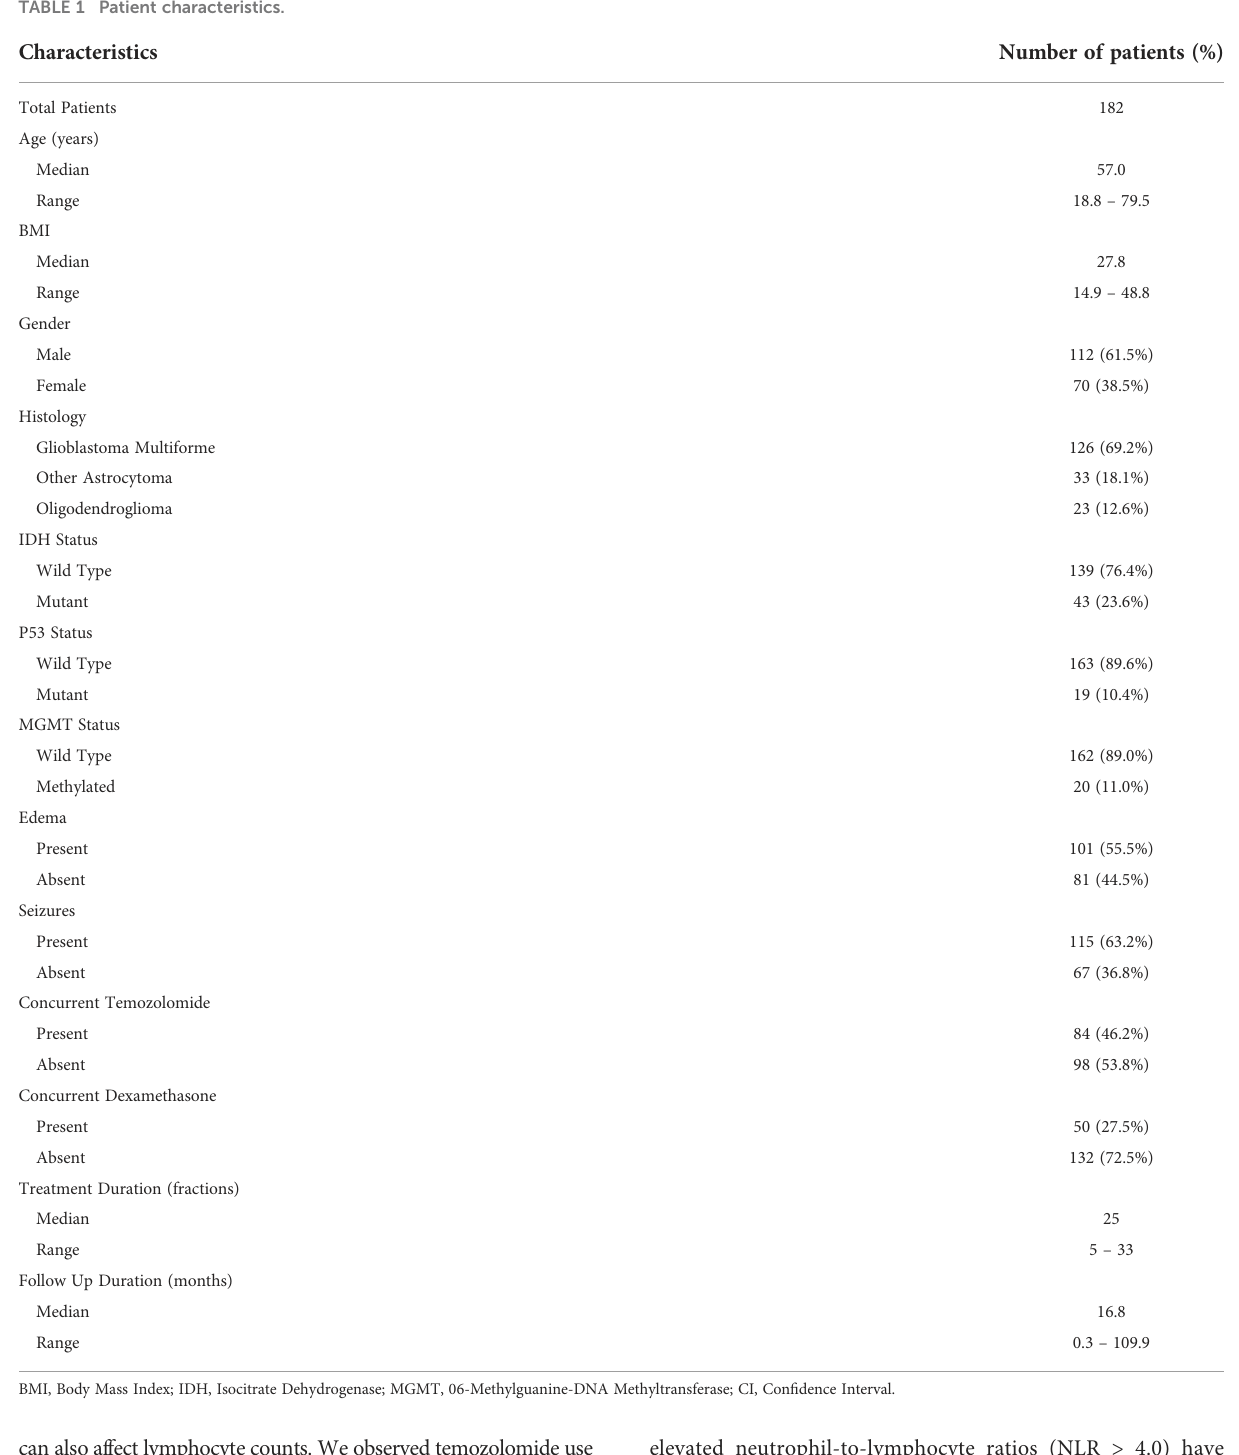
TABLE 1 Patient